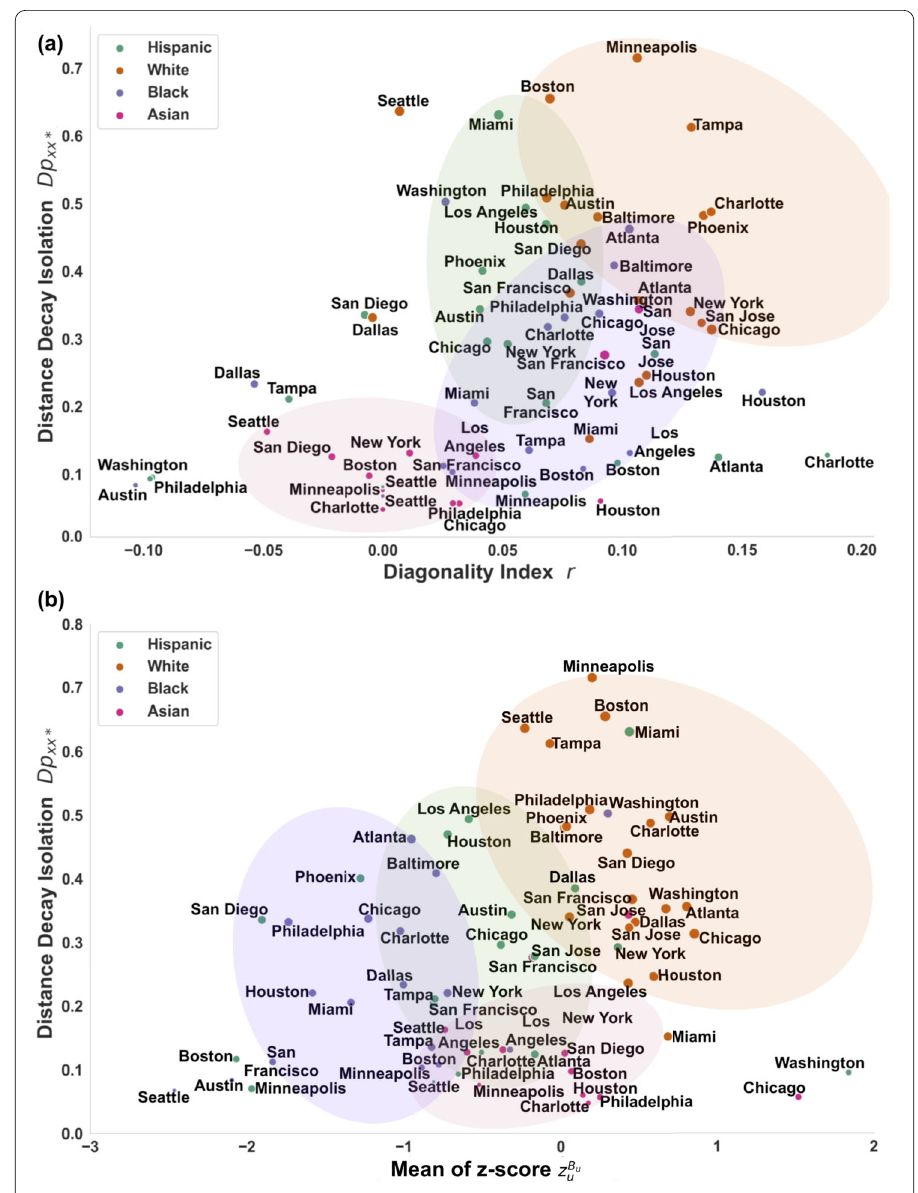
Figure 6 Segregation and bias measure correlations with isolation scores for different ethnic groups. Panel ( a ) depicts the correlation between the diagonality index r N and distance decay isolation Dp xx ∗ while panel ( b ) show a similar correlation of the average individual bias z-score z Bu u . In each plot colours of symbols and blobs indicate ethnic groups of Hispanic (green), White (green), Black (purple) and Asian (red) people. The sizes of symbols are scaled with the size of these ethnic population identified in the Foursquare dataset in each city. Blobs with respected colour illustrate the cluster formation based on racial groupings. The shape is arbitrary, only to demonstrate the visibility of clusters